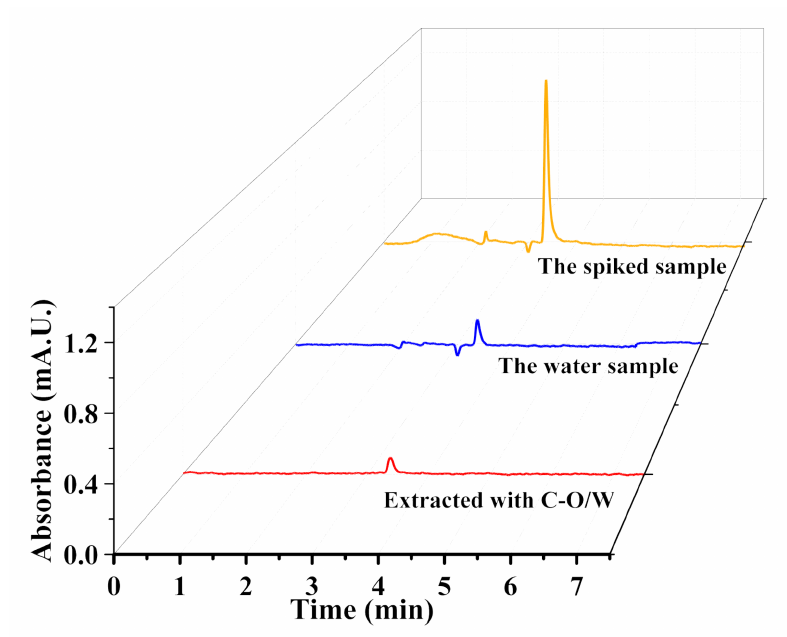
Figure 12. HPLC chromatograms of 3,4,5-TCP-spiked water